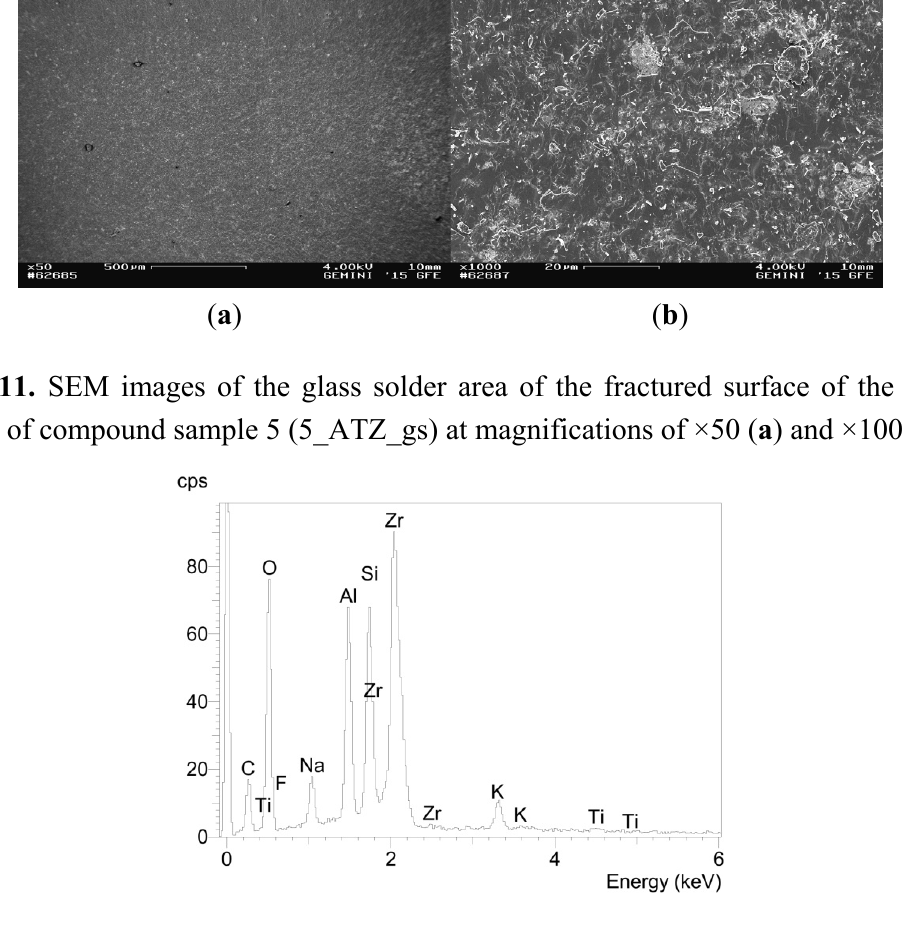
Figure 12. Elemental spectrum for sample 5_ATZ_gs determined using EDX